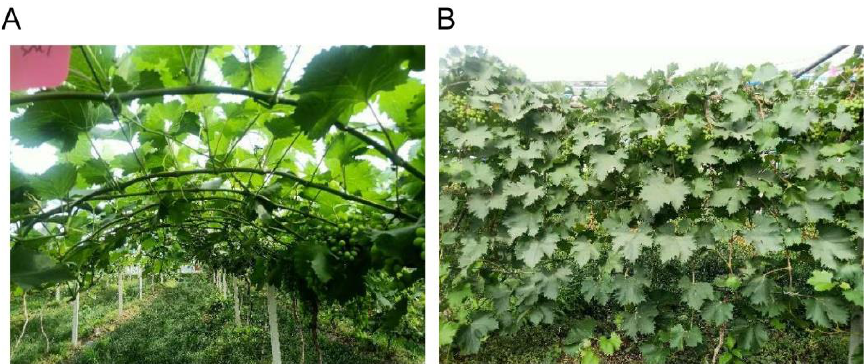
Figure 1. PER (pergola) ( A ) and SCT (single-curtain training system)( B ) of ‘Miguang’ grape.